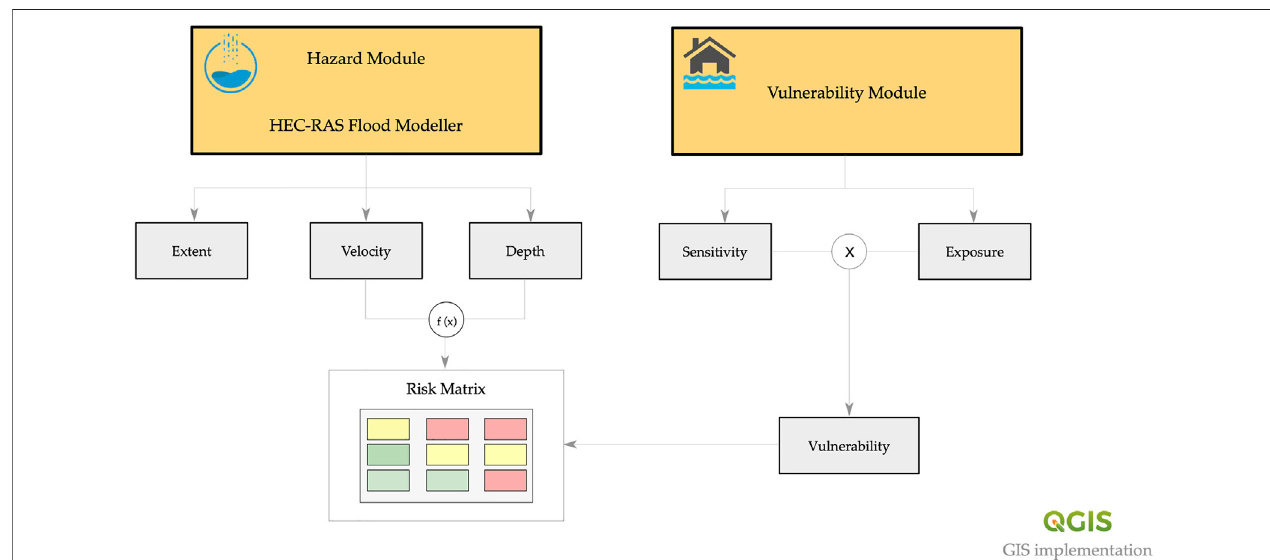
FIGURE 9 | Conceptual framework of the fl ood risk assessment approach proposed by Ferreira and Santos (2020). The fi nal risk matrix is obtained from the combination of hazard and vulnerability results.